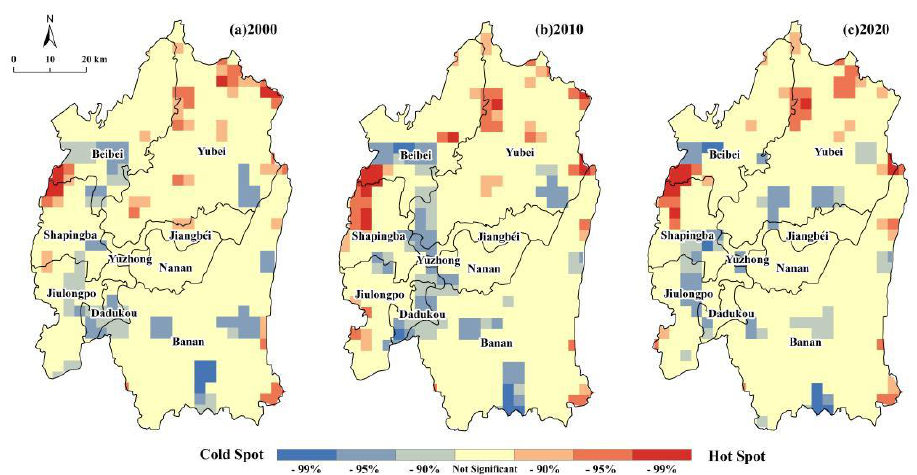
Figure 8. The potential risk of LUCs in the study area .